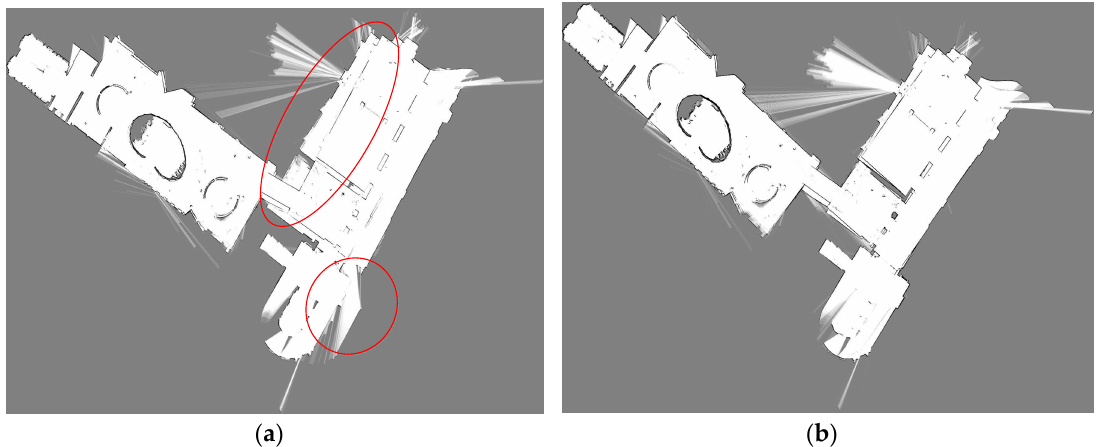
Figure 12. Map built by Cartographer (LiDAR only) ( a ) and the proposed method ( b ) with file b0-2014-07-21-12-42-53.bag [48].